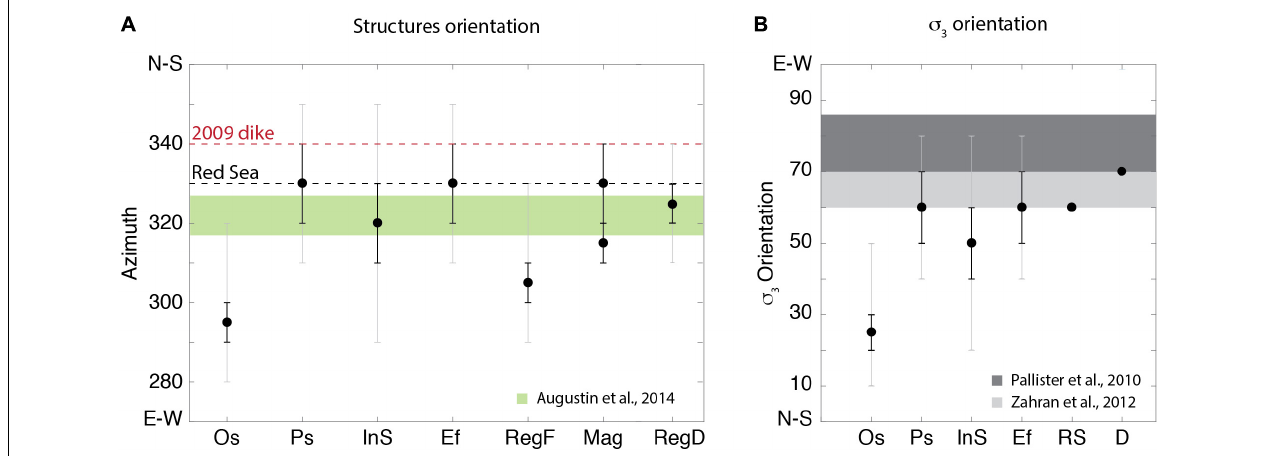
FIGURE 10 | Comparison of (A) magmatic and tectonic structure orientations and (B) minimum compressional stress directions inferred using orientations of magmatic and tectonic structures along with tension axes of focal mechanisms from Pallister et al., 2010 (dark gray) and Zahran, 2017 (light gray). In (A) , the green area indicates the orientation of 736 fractures mapped by Augustin et al. (2014) in the central Red Sea (from latitude 23 ◦ N to 19 ◦ N), the red and black dashed lines indicate the 2009 dike and the overall Red Sea orientation, respectively. Symbols: Os, fractures mapped within oblique segments by using drone data; Ps, fractures mapped within dike parallel segments by using drone data; InS, fractures obtained by InSAR data; Ef, eruptive fissure (or crater rows) from the Harrat Lunayyir volcanic field; RegF, regional faults in the northern Arabian Shield; Mag, aeromagnetic lineations (Zahran, 2017; Zahran et al., 2017); RegD, regional Tertiary dikes; D, 2009 dike; RS, Red Sea. The mean azimuth value in each dataset is indicated by the black dot. Error bars indicate the azimuth range for a given number of features (in %) in each dataset. Black error bars include: 24% of features for Os, 37% for Ps, 34% for InS, 40% for Ef, 16% for RegF, 28% and 30% for Mag, and 42% for RegD. Light gray error bars include: 72% of features for Os, 66% for Ps, 75% for InS, 60% for Ef, 54% for RegF, and 88% for